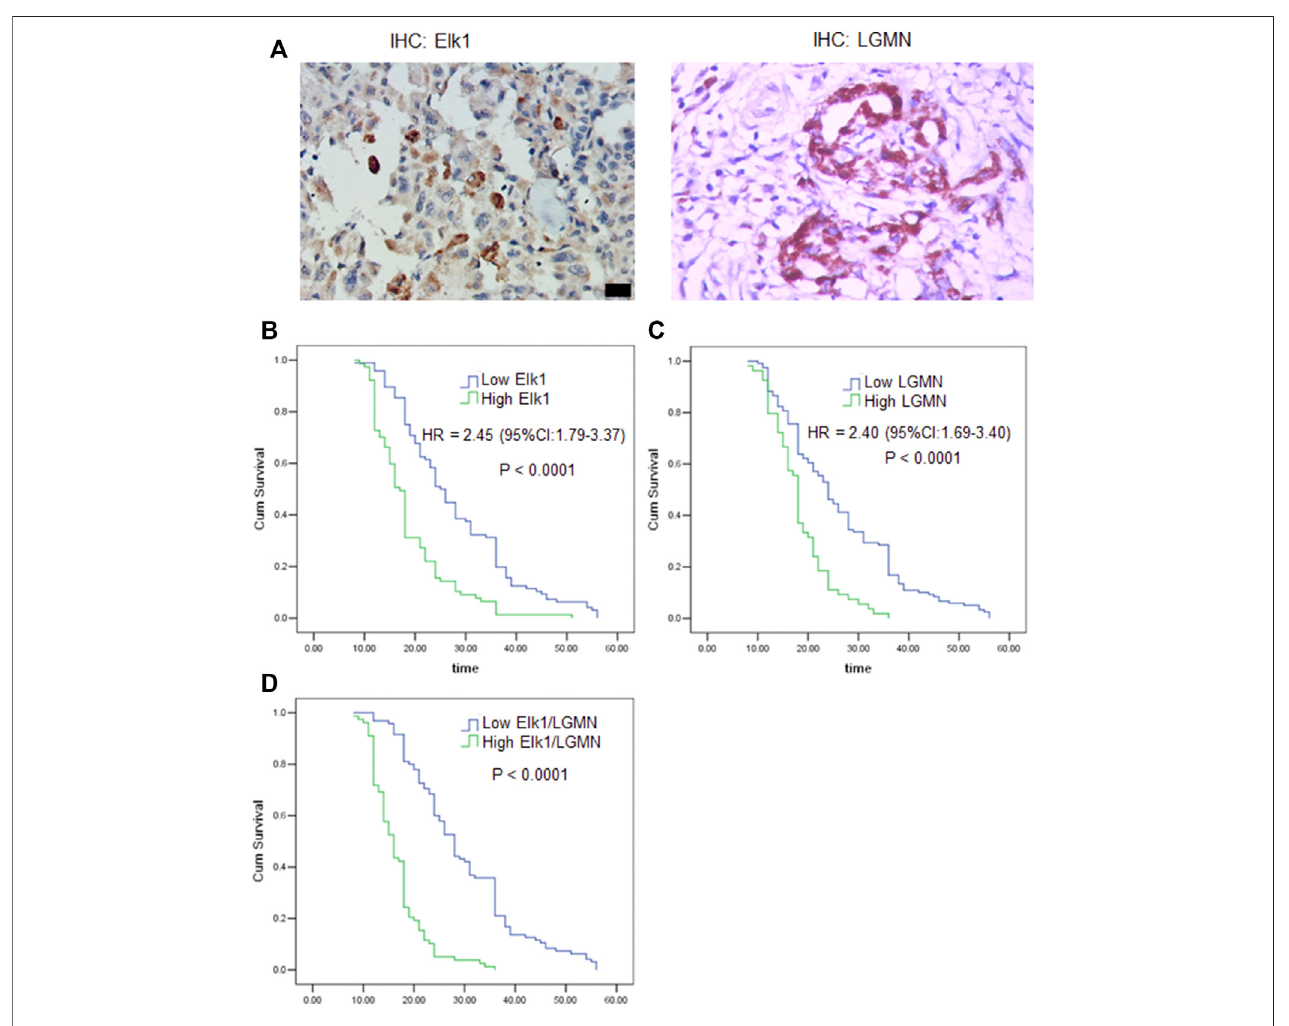
FIGURE 8 | ELK1 and LGMN negatively associated with prognosis in pancreatic adenocarcinoma patients. (A) Expression of ELK1 and LGMN in pancreatic cancer tissues. (B – D) Kaplan-Meier survival analysis in PDAC patients ( n (cid:1) 173) according to the ELK1 and LGMN expression. High ELK1 (B) , LGMN (C) and both (D) expression patients showed signi fi cantly shorter 5-year OS than patients with low ELK1 (B) , LGMN (C) and both (D) expression in their tumors by long-rank test ( p <